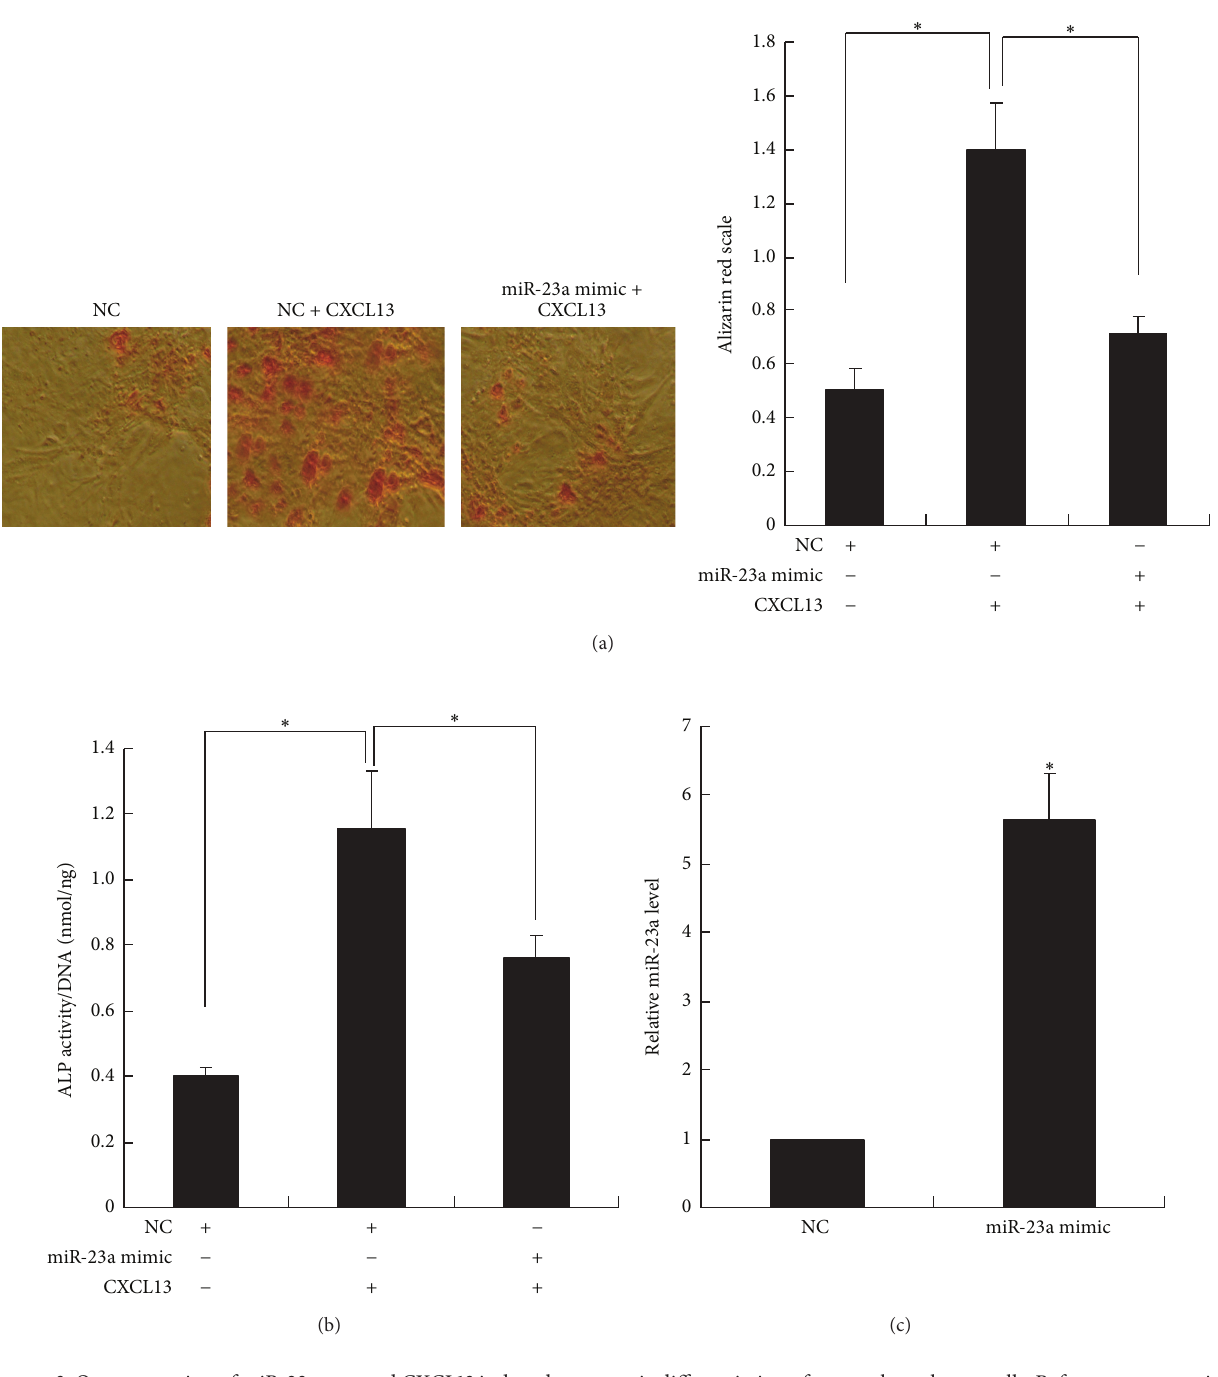
Figure 3: Overexpression of miR-23a reversed CXCL13 induced-osteogenic differentiation of mesenchymal stem cells. Before treatment with CXCL13 recombinant protein, BMSCs were transfected with a miR-23a mimic. The cells were incubated for 17 days for further analysis. (a) Representation of calcium nodes by alizarin red staining. (b) ALP activity. (c) Expression of miR-23a using Q-RT-PCR. All values represent means ± SD ( 𝑛 = 3 ). ∗ 𝑃 < 0.05 compared with corresponding